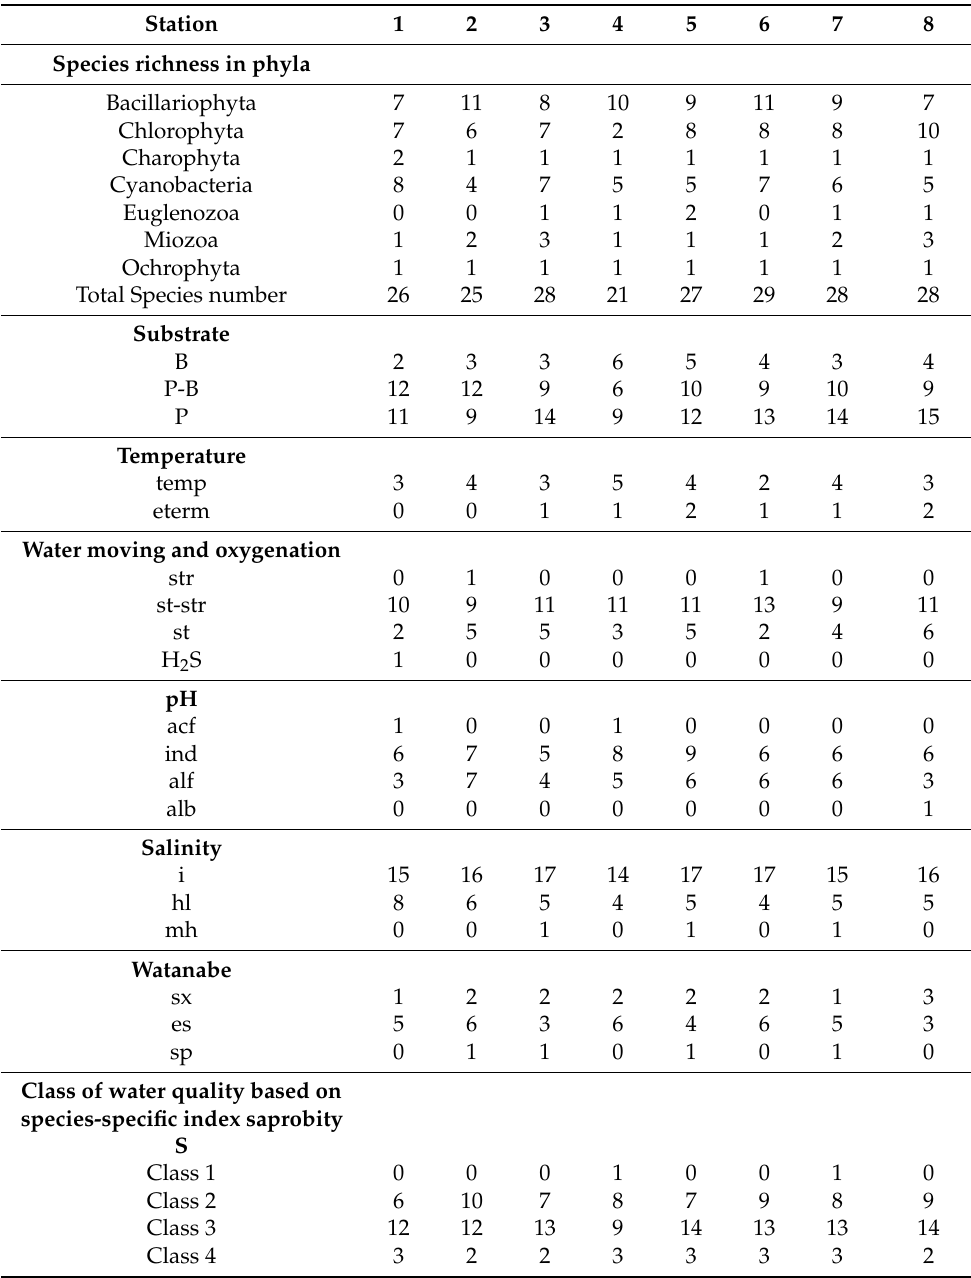
Table A3. Distribution of species richness in phyla, total species number in community, and ecological properties of bioindicators for sampling stations on Lake Borovoe, 2019. Abbreviations: B, benthic; P- B, plankto-benthic; P, planktonic; temp, inhabitants of temperate-temperature waters; eterm, euryther- mic; str, inhabitants of streaming well-oxygenated waters; st-str, inhabitants of standing to streaming middle-oxygenated waters; st, inhabitants of standing low oxygenated waters; H2S, sulfides anoxia indicators; acf, acidophilic; ind, pH-indifferent; alf, alkaliphilic; alb, alkalibiontes; i, chlorides indiffer- ents; hl, halophiles; mh, mesohalobes; sx, saproxenes; es, eurysaprobes; sp, saprophiles; Classes 1–4 of water-quality indicators according to Index S; o, oligotraphentes; o-m, oligo-mesotraphentes; m, mesotraphentes; me, meso-eutraphentes; e, eutraphentes; o-e, oligotraphentes to eutraphentes; ats, autotrophes-inhabited low-nitric-nitrogen waters; ate, autotrophes-inhabited high-nitric-nitrogen waters; hne, facultative-heterotrophes-inhabited low organically enriched waters.